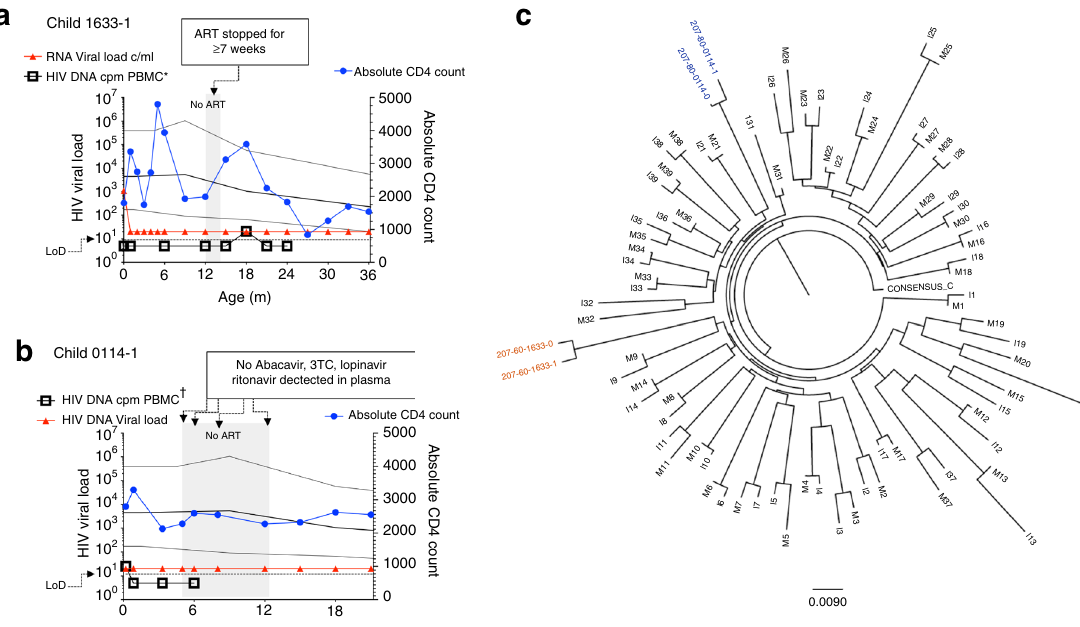
Fig. 4 Lack of viral rebound in two male subjects following signi fi cant periods of ART non-adherence. a Male subject 1633-1 received no ART for at least 7 weeks at 12 – 14 months ’ age: pharmacy records show that the aunt of the child did not collect any ART medication for 2 months following the return of the child ’ s mother to work 12 m after the child ’ s birth. ART was restarted 7 days prior to the viral load test at 15 m. Undetectable DNA viral loads are shown as 5 HIV DNA cpm PBMC. Only the 18 m timepoint was above the limit of detection (DNA load 21 cpm PBMC). b Male subject 0114-1: none of the drugs prescribed were detected in plasma tested over a 7-month period (age 5 – 12 months). At age 15 months and 18 months, only 1 and 2 of the 4 drugs prescribed were detected at therapeutic levels, respectively. Undetectable DNA viral loads are shown as 5 HIV DNA cpm PBMC. Only the baseline timepoint (at 7 days ’ age) was above the limit of detection (DNA load 25 cpm PBMC). c Gag was ampli fi ed from plasma from the baseline sample from both these mother-child pairs and the sequences determined clustered on a phylogenetic tree, consistent with HIV infection and mother-to-child transmission in each case. Diagnosis in these cases, as in all the in utero-infected infants in the cohort, was determined by 2 or more tests from separate blood samples detecting HIV nucleic